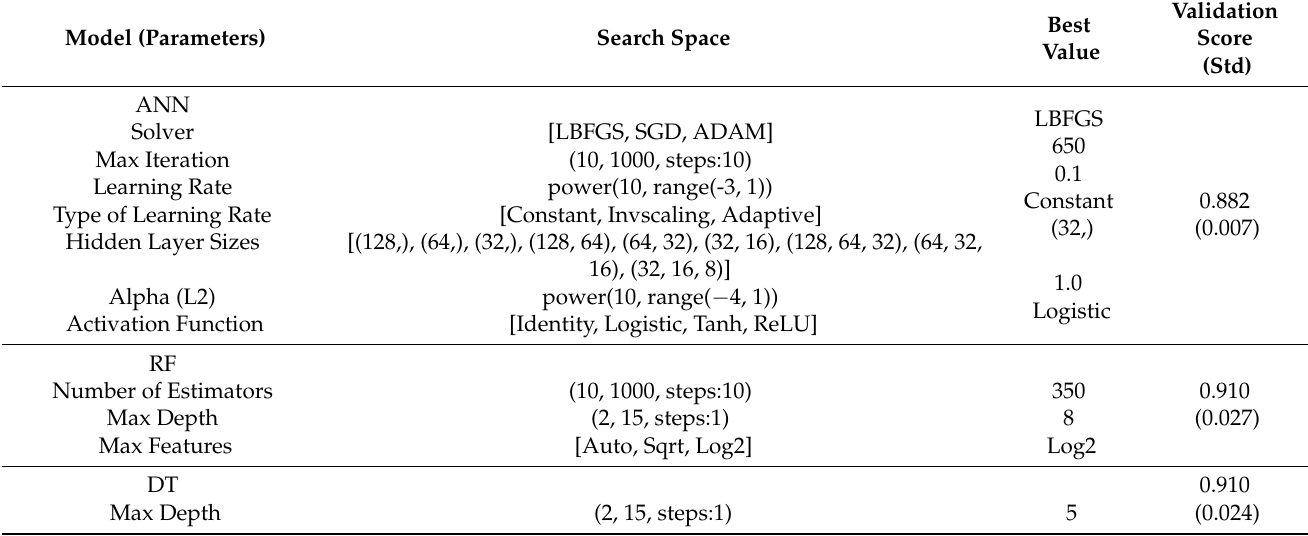
Table 3. Summary results of optimisation of machine learning